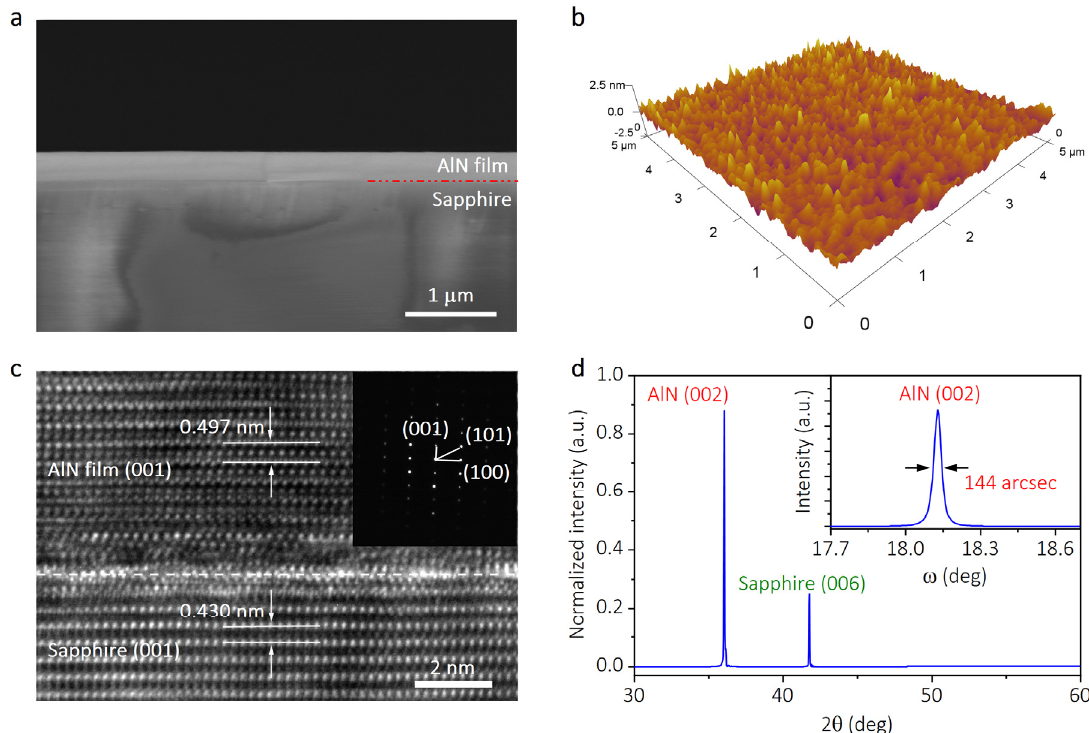
Figure 2. The characterizations of aluminum nitride (AlN) thin film. ( a ) Cross-sectional SEM image of the AlN thin film grown on sapphire substrate. ( b ) AFM image of the AlN thin film, with a scan size of 5 × 5 µ m 2 . ( c ) Cross-sectional HRTEM image of the AlN film sample, with the corresponding selected area electron diffraction (SAED) pattern of the AlN layer shown in the inset. ( d ) X-ray diffraction (XRD) pattern of the AlN sample showing two diffraction peaks, corresponding to AlN (002) and sapphire (006). The inset shows the rocking curve of the AlN (002)